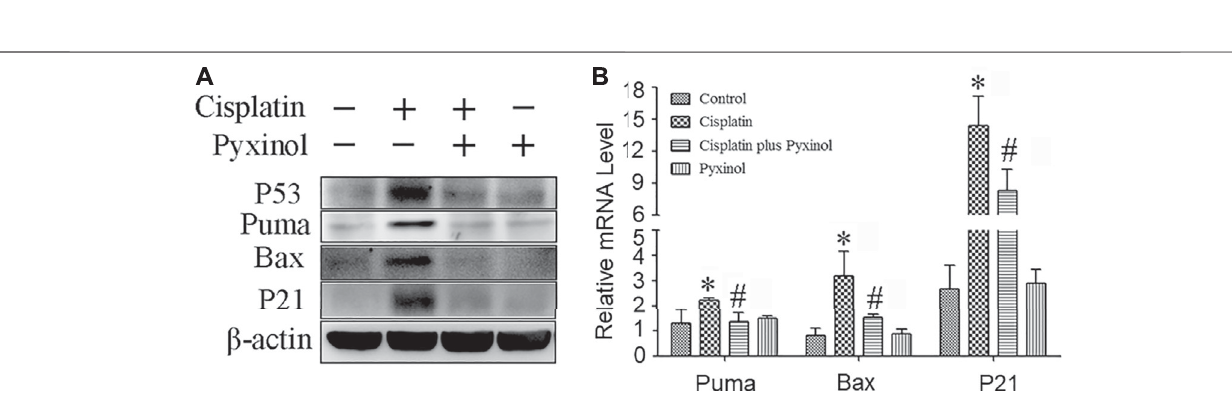
FIGURE 5 | Effects of pyxinol on the expression of P53 and its transcription activity induced by cisplatin in rats. (A) Representative western blotting band; (B) quanti fi cation of mRNA levels as measured by real-time PCR. *p < 0.05, compared with the control group; #p < 0.05, compared with the cisplatin group.